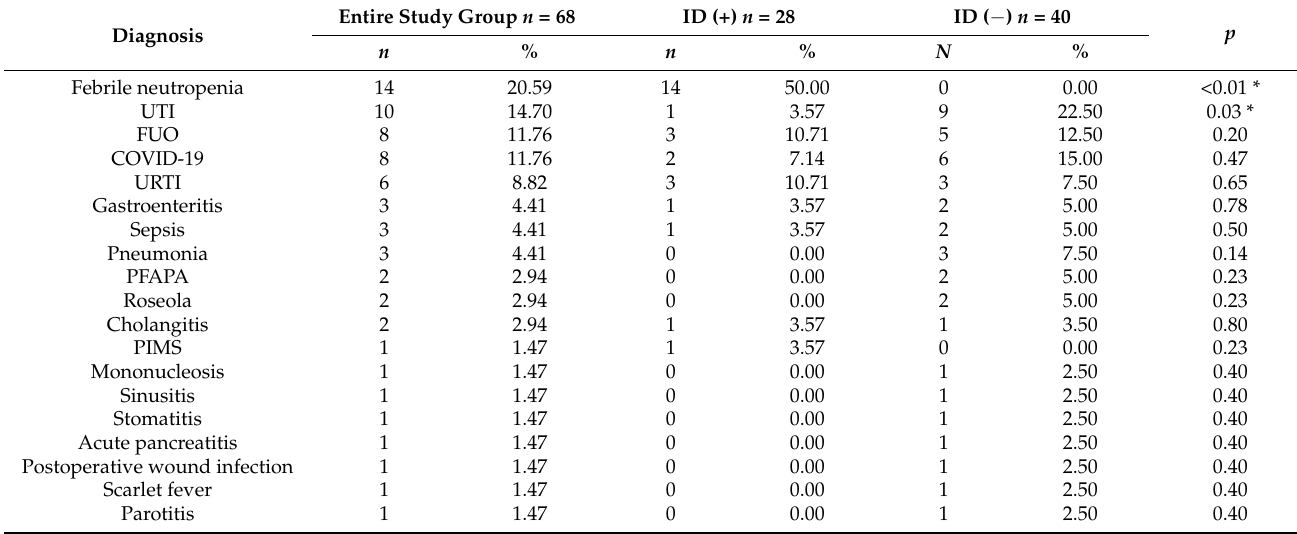
Table 2. Final diagnosis in children who had isolated fever.